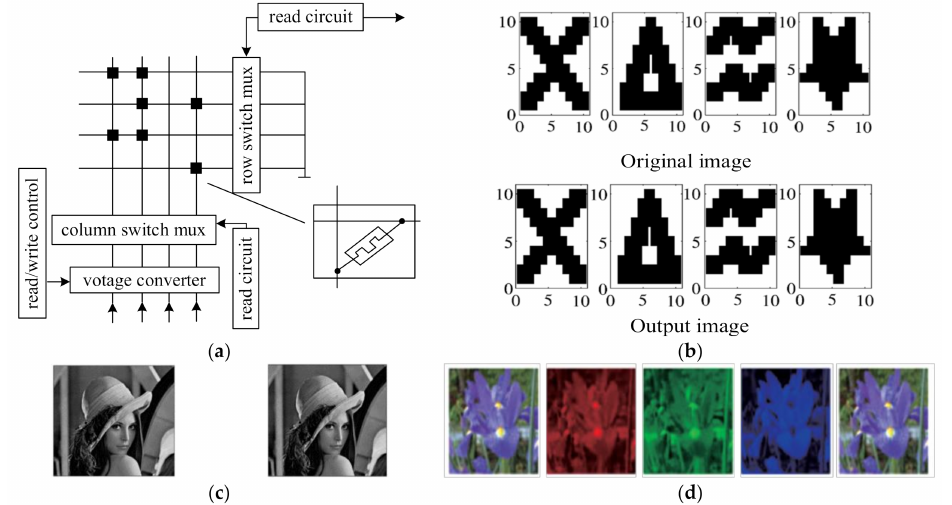
Figure 4. Application of memristor crossbar array in image storage. ( a ) memristor crossbar array; ( b ) memristor crossbar array used to store binary images; ( c ) memristor crossbar array used to store grey scale images; ( d ) memristor crossbar array used to store color